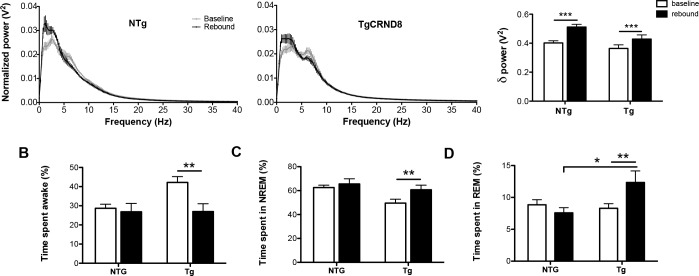
Three-month-old TgCRND8 mice differ from NTg in their homeostatic response to total sleep deprivation.Normalized NREM sleep power spectrums from 0.125–40 Hz and quantification of NREM delta power (0.5–4.5 Hz) (A), time spent awake (B), time spent in NREM sleep (C), and time spent in REM sleep (D) under baseline and rebound conditions in 3-month-old NTg (n = 7) and TgCRND8 mice (n = 9). Total sleep deprivation (TSD) was performed for 6 hours, beginning at the onset of the light phase. The rebound period corresponds to the 2-hour period immediately following TSD. (A) Both TgCRND8 and NTg mice show a significant shift towards higher NREM delta power during the rebound period in comparison to baseline. Interestingly, the NREM delta power rebound response was blunted in TgCRND8 mice, with an 18% and 27% increase between baseline and rebound in TgCRND8 and NTg, respectively. (B) TgCRND8 show a significant decrease in time spent awake during the rebound period in comparison to baseline. No significant change in time spent awake during the rebound period in comparison to the baseline period was observed in NTg, and this response did not differ significantly from TgCRND8. (C) TgCRND8 show a significant increase in time spent in NREM sleep during the rebound period in comparison to baseline. No significant change in time spent in NREM sleep during the rebound period in comparison to the baseline was observed in NTg, and this response did not differ significantly from that observed in TgCRND8. (D) TgCRND8 show a significant increase in time spent in REM sleep during the rebound period in comparison to baseline. No significant change in time spent in REM sleep during the rebound period in comparison to the baseline period in NTg, and this response differed significantly from that observed in TgCRND8. Time spent in REM sleep during the rebound period was significantly greater in TgCRND8 in comparison to NTg. Error bars represent SEM. Mixed design two-way ANOVAs followed by simple effects analysis or Tukey’s post hoc where appropriate, * P<0.05, ** P<0.01, *** P<0.001.